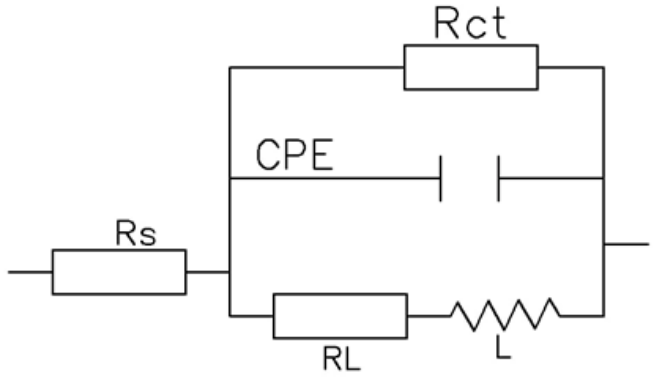
Figure 7. Equivalent potential circuit for the fitted model.